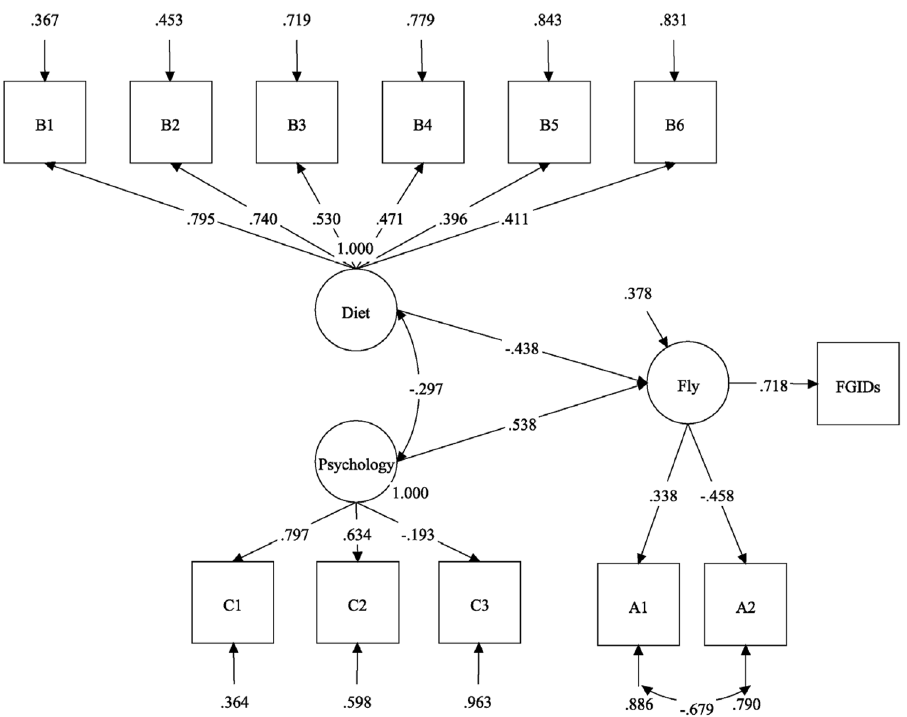
Figure 2. Parameter estimates (standard regression coefficients) of the structure equation model for the effects of the trigger factors on the FGIDs. A1: age, A2: flight level, B1-B6: six food categories with factor loading > 0.4 in the high-salt food pattern, which were B1: chicken, B2: animal giblets, B3: Chinese pickles, B4: water food (one of Chinese pickled vegetable), B5: preserved meat and B6: bacon, C1: anxiety, C2: depression, C3: sleep